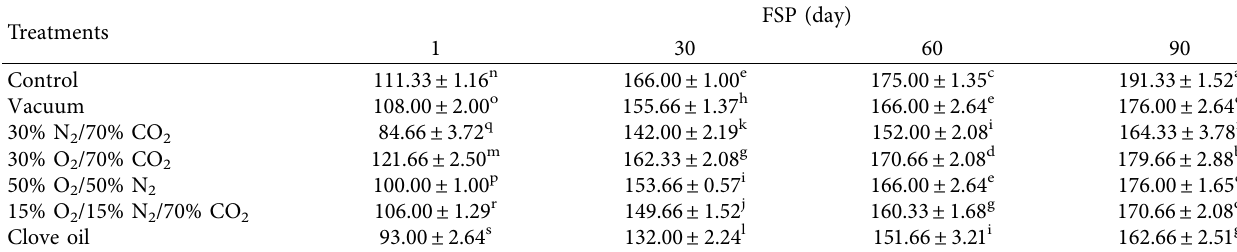
Table 2: Impact of MAP and FSP on the MFI of CTMP.